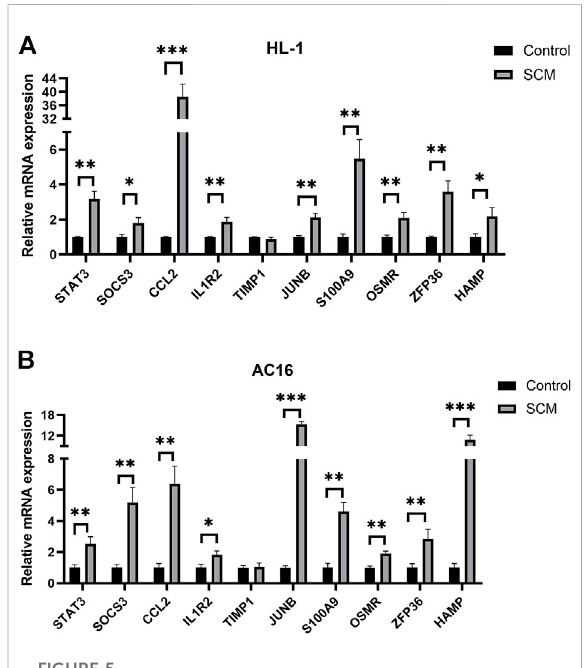
FIGURE 5 ResultsofQuantitativereal-timePCRexperimentsforthetop tengenes(* < 0.05,** < 0.01,*** < 0.001). (A) ExpressionofHubgene in HL-1 cells. (B) Expression of Hub gene in AC16